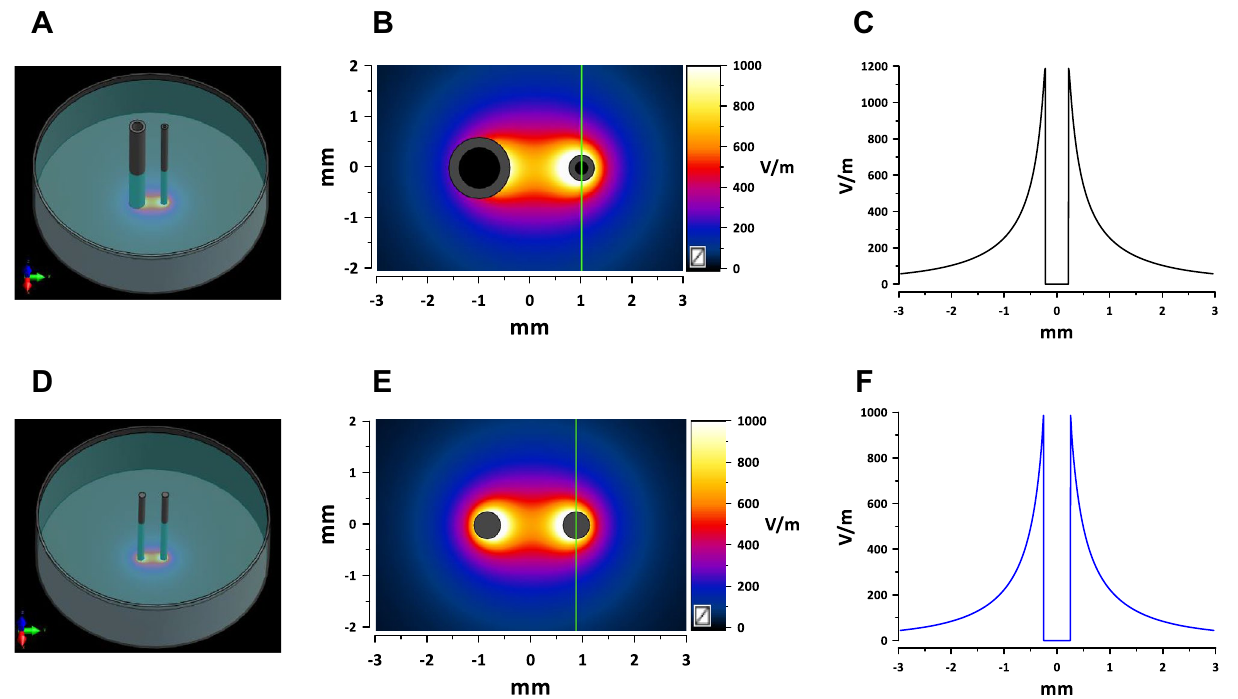
Figure 2. Electric field simulations for the asymmetrical ( A – C ) and symmetrical (D – F) electrode assemblies. ( A ) and ( D ) show the spatial configuration of the electrode assemblies orthogonal to a plastic dish and touching its bottom. ( B ) and ( E ) show the calculated electric field distribution in a plane 5 µm above the bottom with 1 V applied between electrodes. The direction in which the electric field thresholds were measured is marked by vertical green lines (see text). ( C ) and ( F ) are the electric field values along the green lines. These values were linearly scaled to the voltage applied between the electrodes for calculation of the electric field